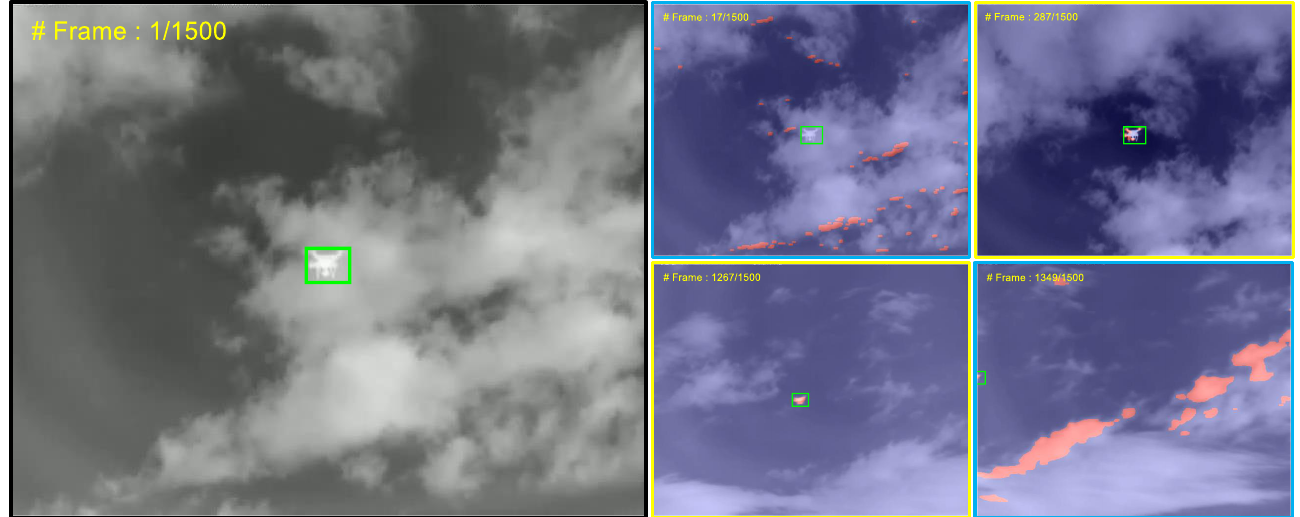
Figure 3. Motion features of CDCF. The areas with motion features are marked in pink, the rest in blue. When background is static e.g., frame 287, 1267, the motion feature is quite distinct, which is suitable for CDCF to perceive target, even the target is tiny and with little semantic information. When dynamic background occurs e.g., frame 17, 1349, the moving clouds in the scene will cause a heavy disturbance in discerning the real